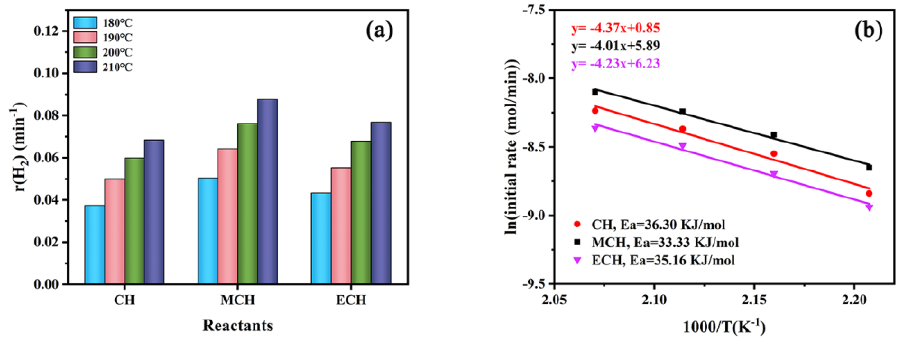
Figure 8. ( a ) r vales at 180 – 210 °C; ( b ) Arrhenius plots for CH, MCH and ECH dehydrogenation with Pt/CN catalyst.